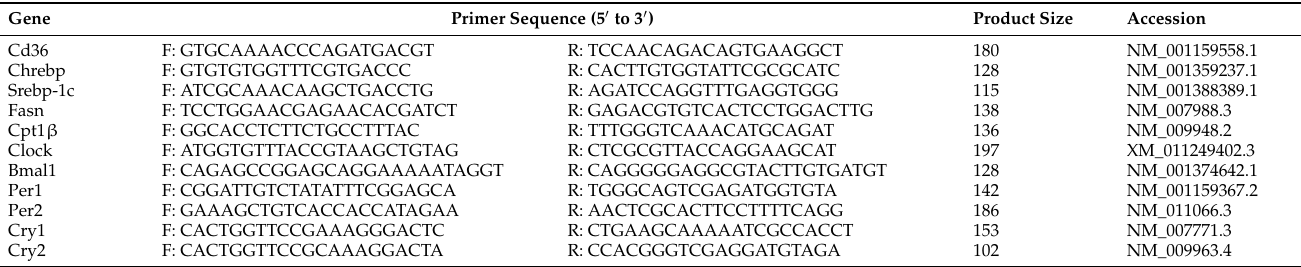
Table 2. Sequences of primers used for